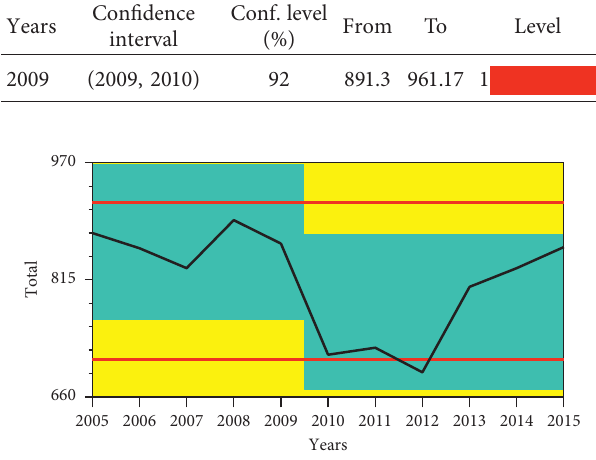
Figure 12: Mpumalanga: background changes.